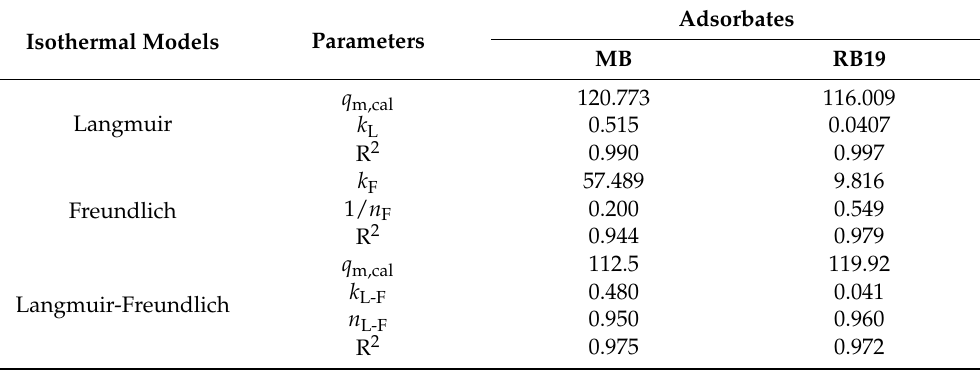
Table 2. Parameters of isothermal models for the adsorption of MB and RB19 onto N-CM. Isothermal